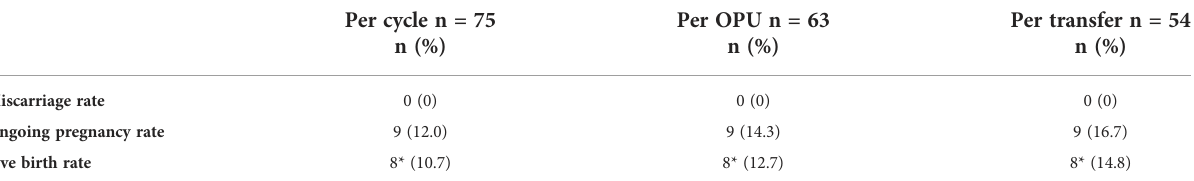
TABLE 4 SAS cumulative IVF outcomes.